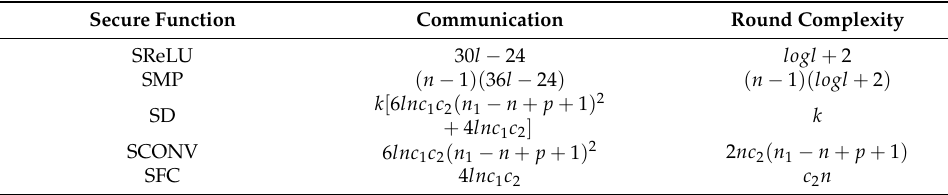
Table 3. Communication Complexity Analysis of